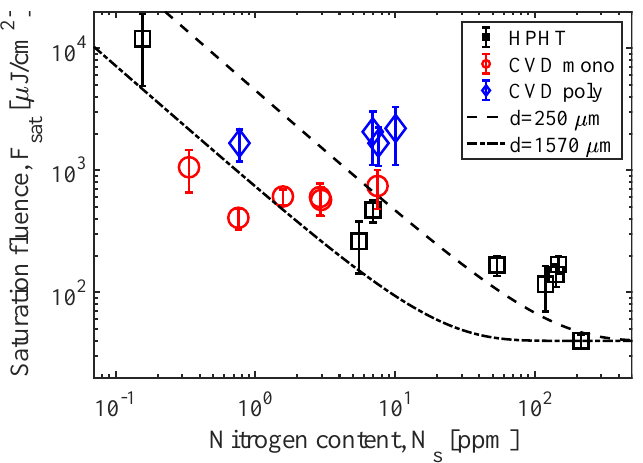
Figure 6. Dependence of saturation laser fluence on nitrogen concentration for tested diamond emit- ters. The lines indicate theoretical estimations of PCA performance for 250- µ m-thick and 1570- µ m- thick substrates (see text for